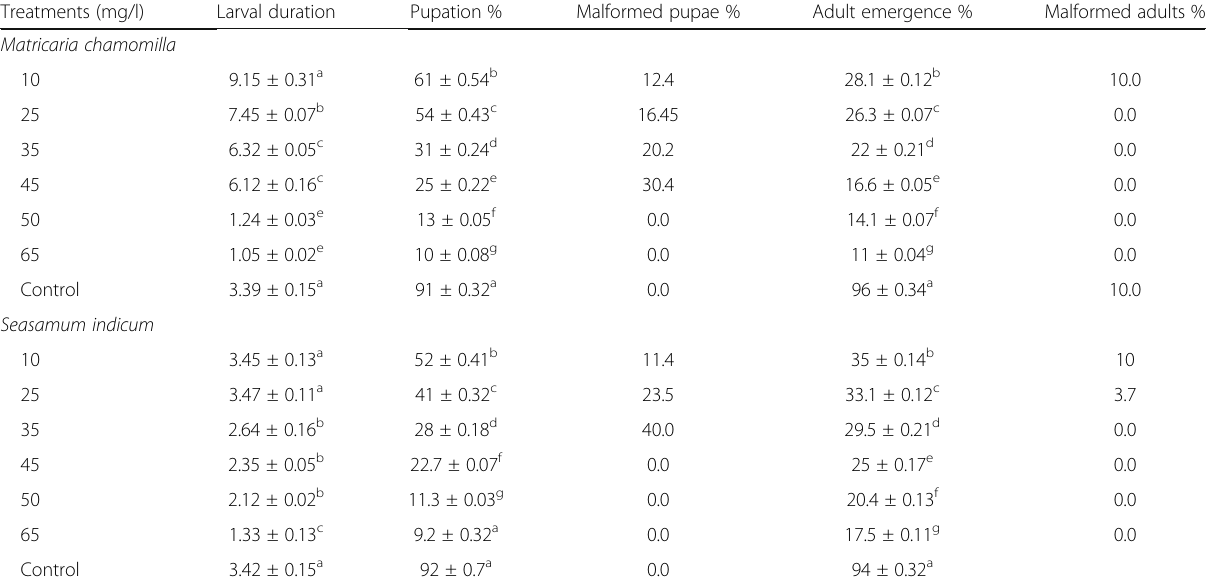
Table 3 Effect of Bacillus thuringiensis var. israelensis and some plant extracts on some biological aspects after treatment of 4th instar larvae of Culex